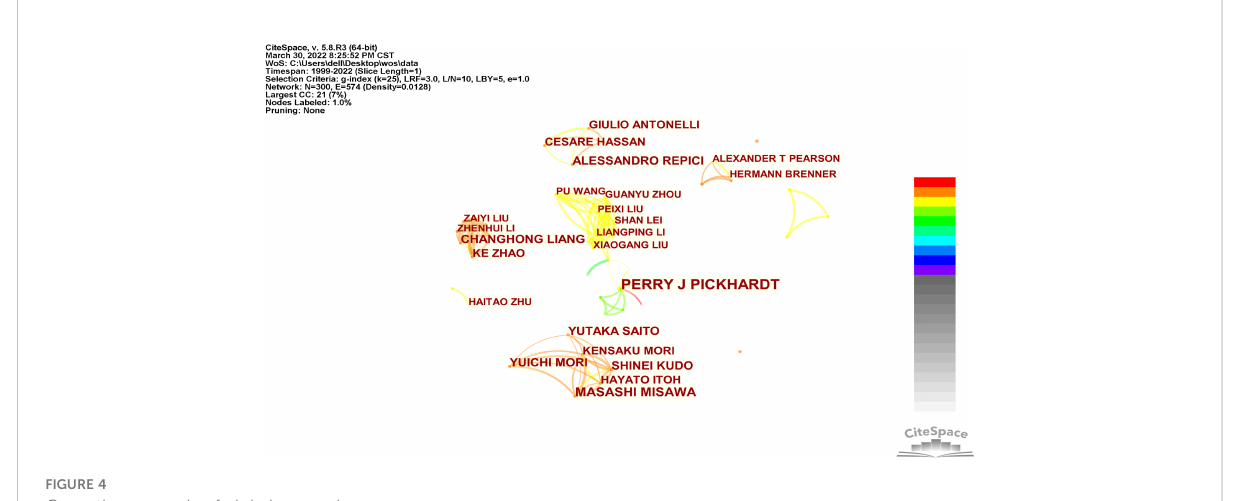
FIGURE 4 Co-authors anaysis of global research.